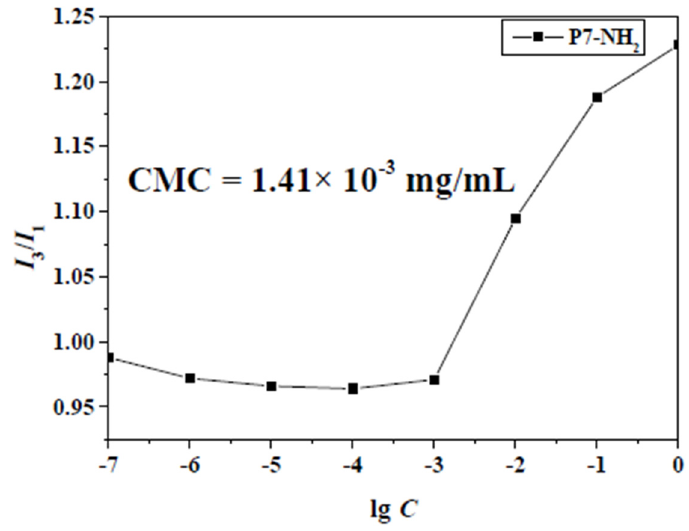
Figure 4. Plot of fluorescence intensity of pyrene as a function of the concentration of PBnMA- b -P(APMA- co -PEGMA) in aqueous solution. P7: PBnMA 12 - b -P(BAPMA 8 - co -PEGMA 6 ). I 3 / I 1 = A 384 nm /A 373 nm.